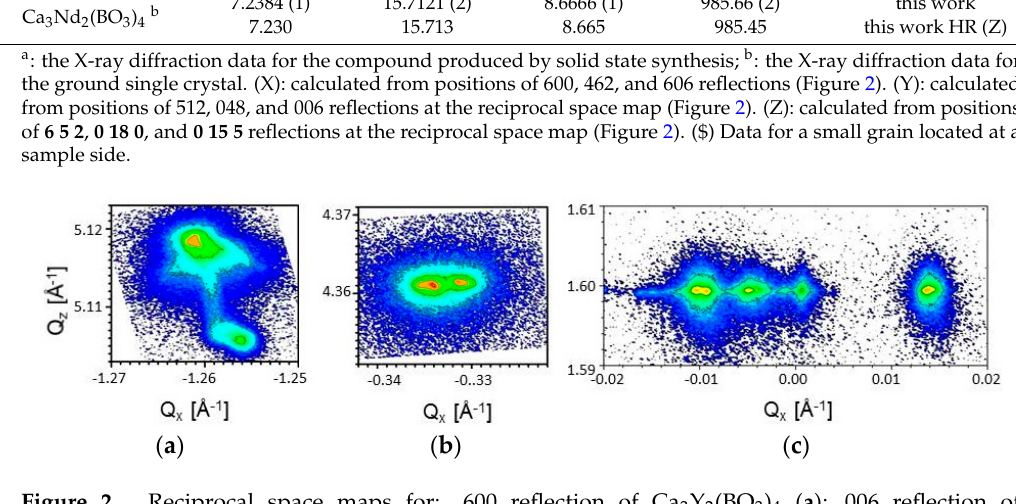
Figure 2. Reciprocal space maps for: 600 reflection of Ca 3 Y 2 (BO 3 ) 4 ( a ); 006 reflection of Ca 3 Gd 2 (BO 3 ) 4 ( b ); 040 reflection of Ca 3 Nd 2 (BO 3 ) 4 ( c